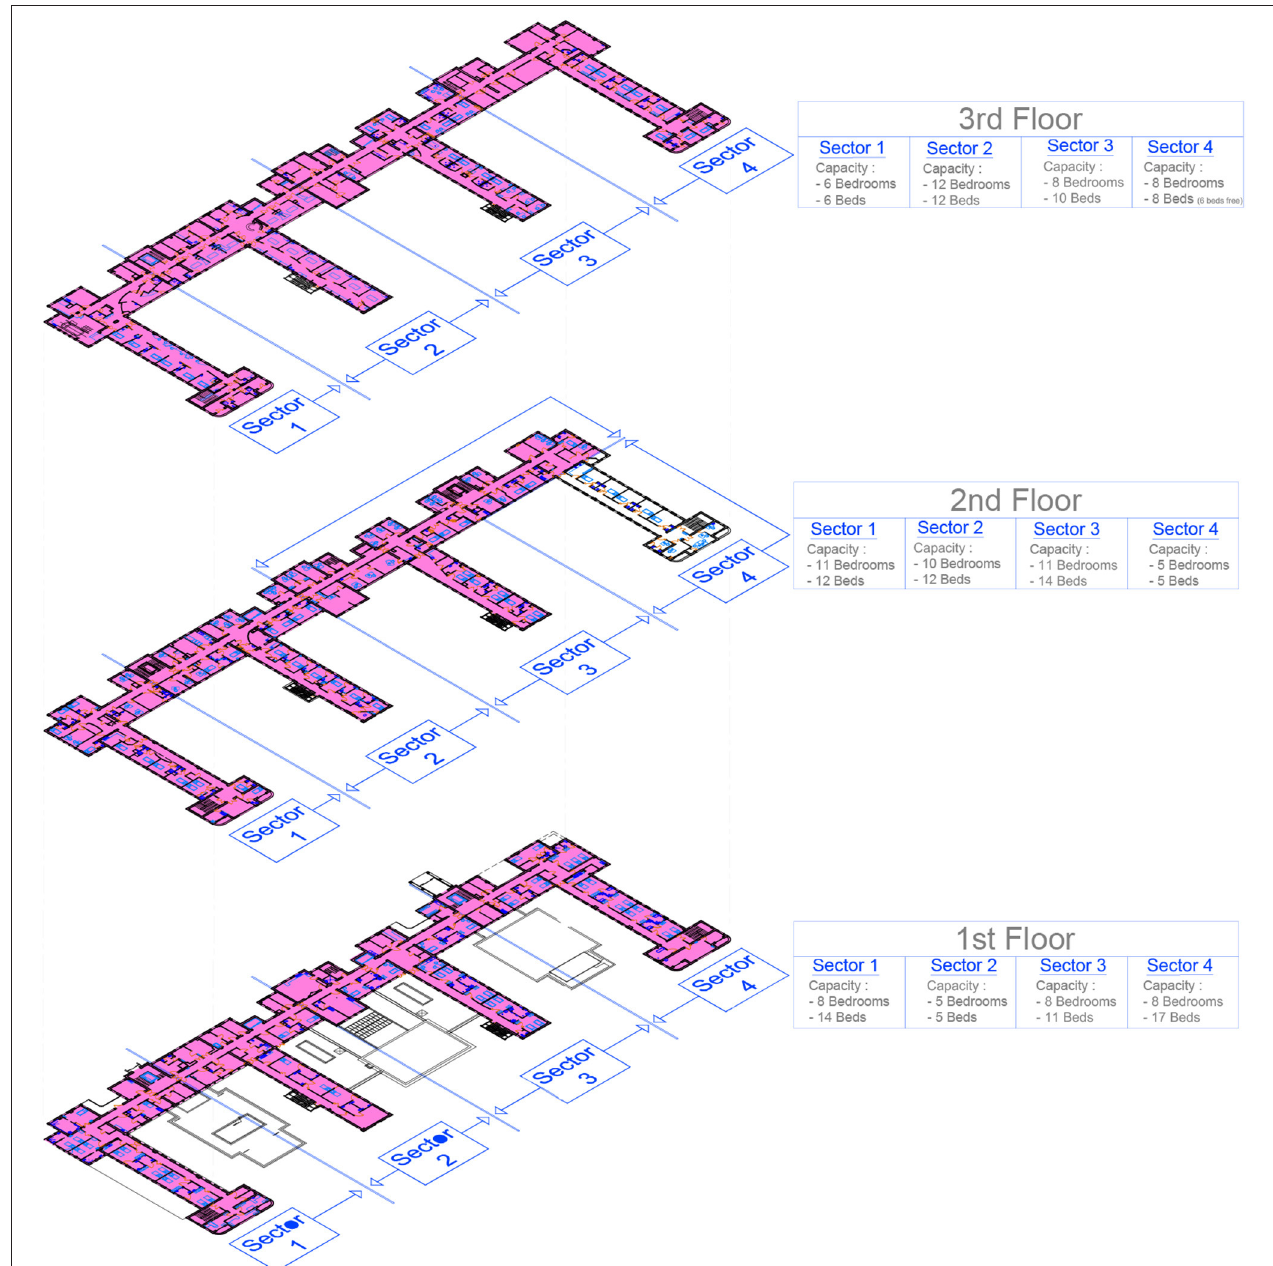
FIGURE 1 | Detailed plan of the COVID building units (in pink color, units dedicated for COVID).